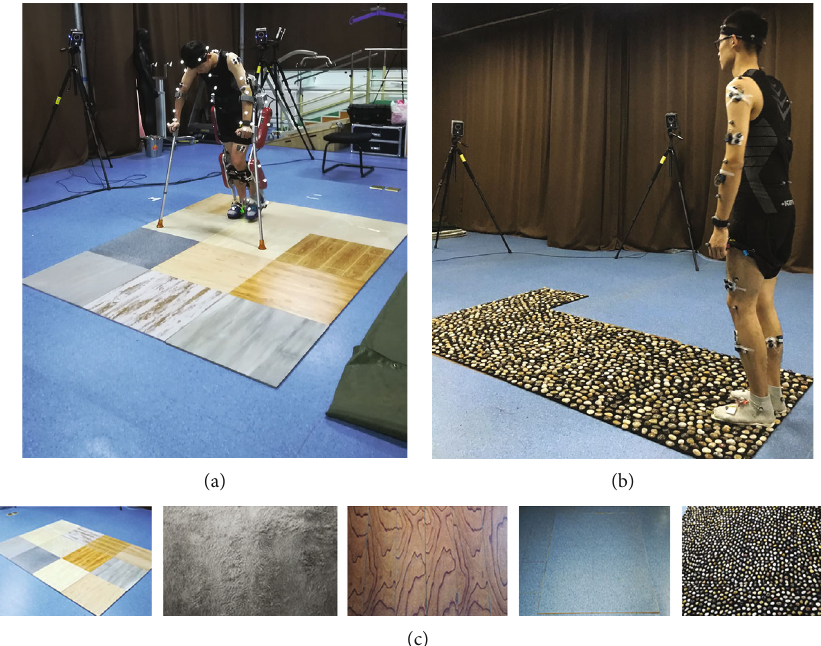
Figure 1: Experimental environment: (a) participant with exoskeleton walking on tiled pavement, (b) participant without exoskeleton walking on pebbled pavement, and (c) tiled pavement, carpet pavement, wooden pavement, concrete pavement, and pebbled